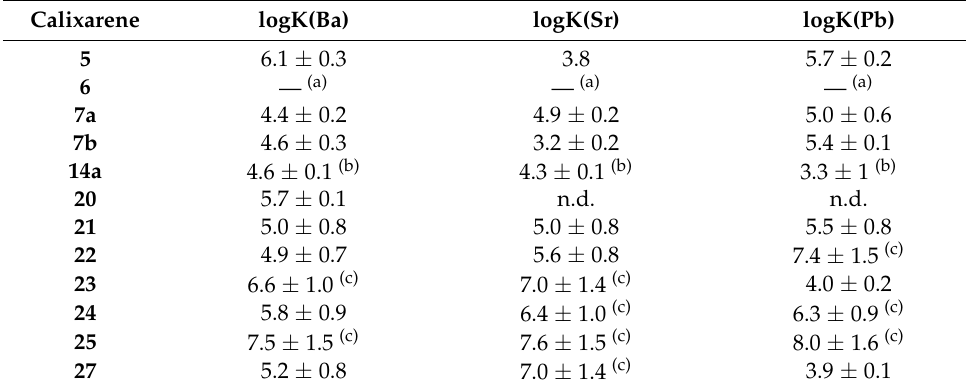
Figure 4. UV/Vis spectra of calix[4]arene 21 at different M(ClO 4 ) 2 concentrations ( A ) M = Ba, ( B ) M = Sr, ( C ) M = Pb for titration measured in acetonitrile. ( D ) Titration curve with change of the absorption using compound 21 at different Ba(ClO 4 ) 2 concentrations, measured in acetonitrile at λ = 275 nm. Table 2. Determined logK values using the UV titration